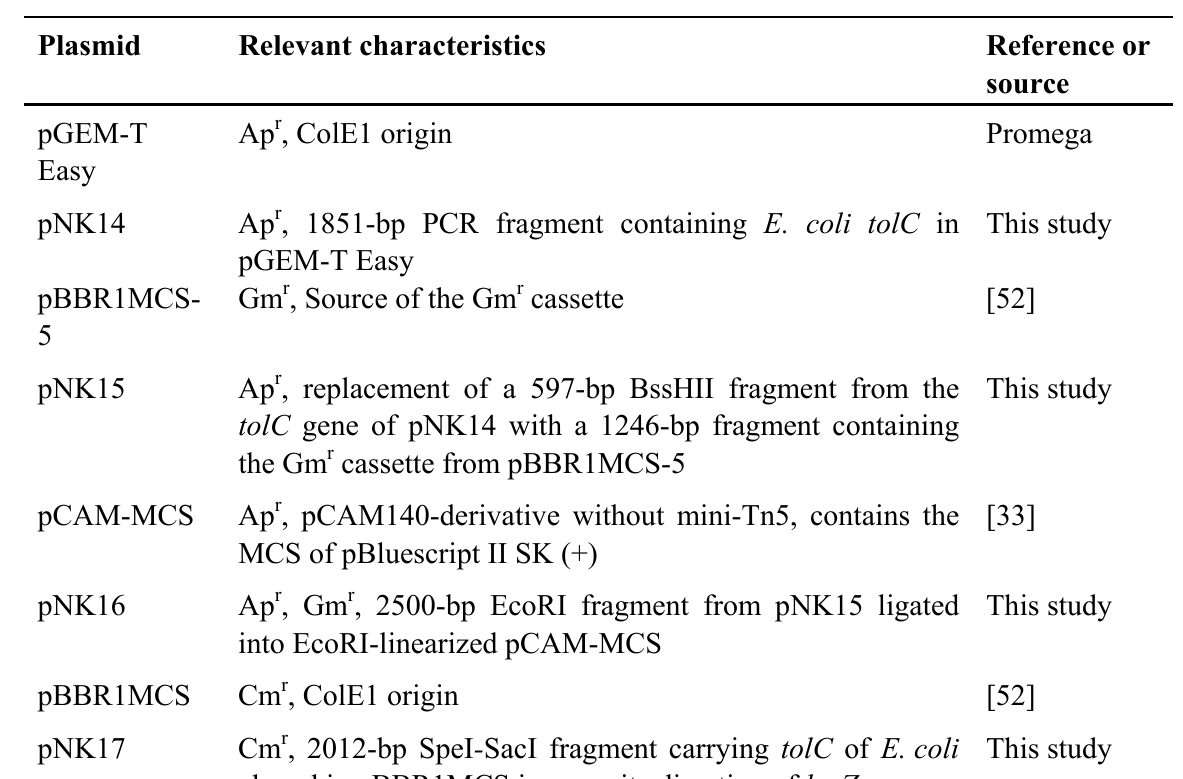
Table 6. Plasmids used in this